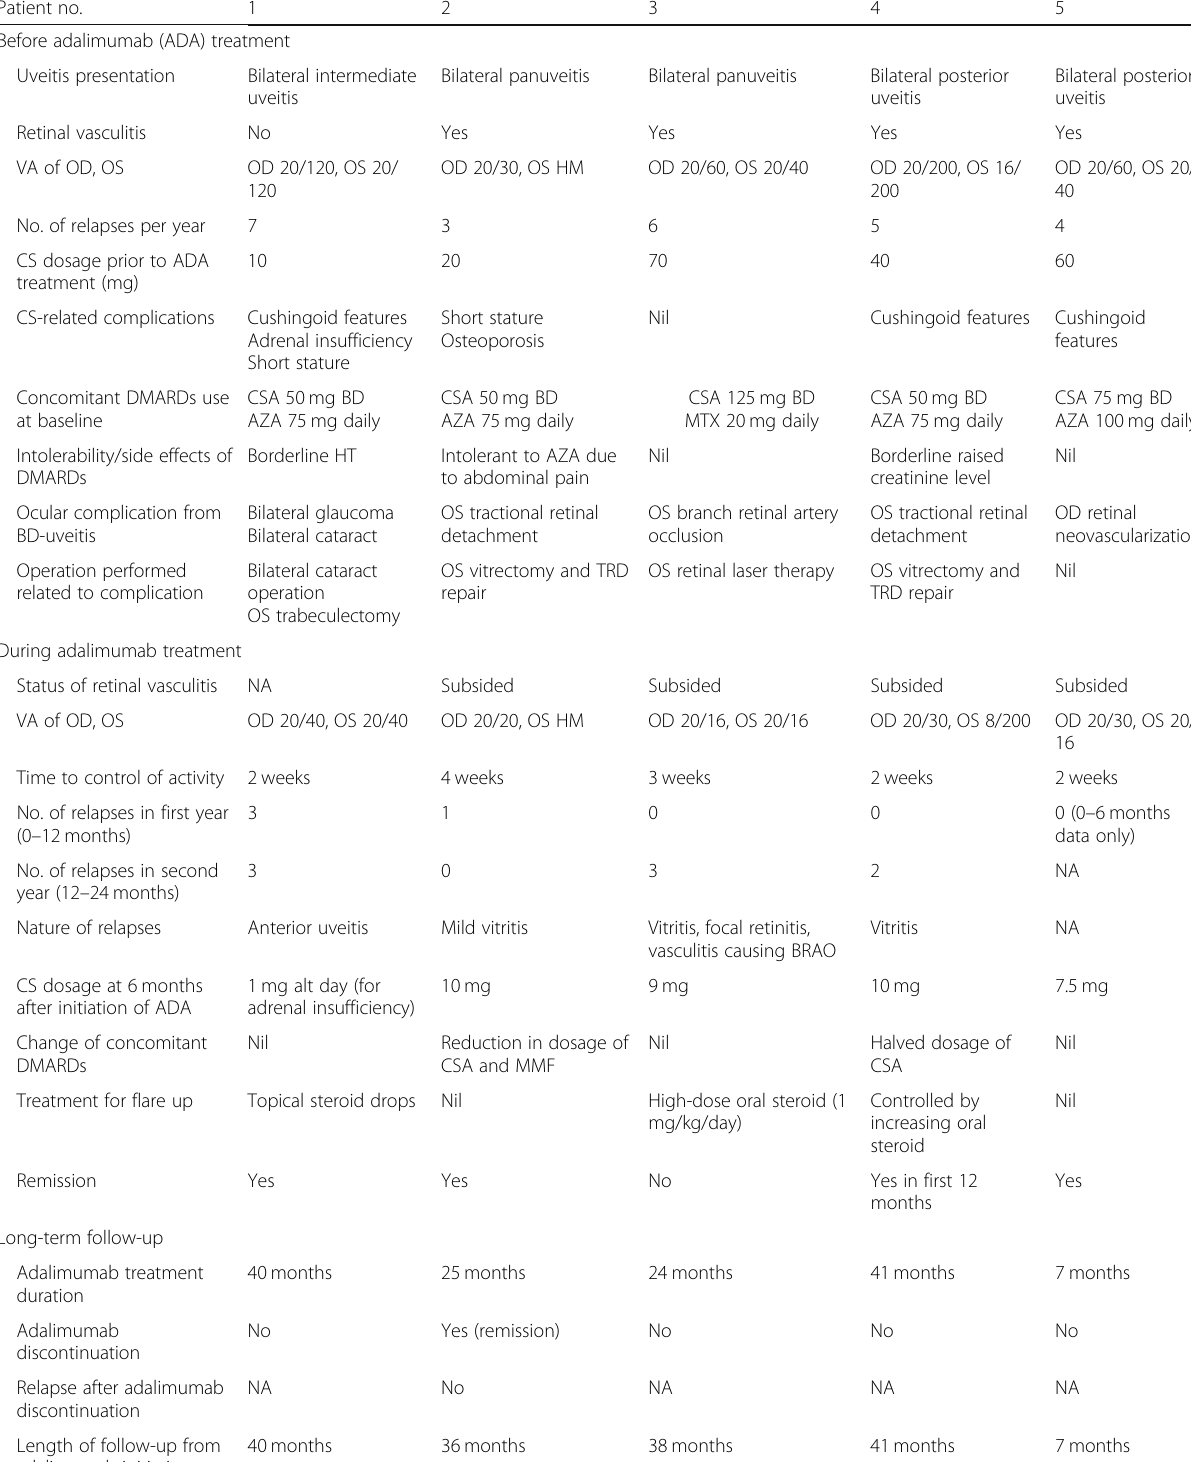
Table 2 Clinical response and treatment efficacy of adalimumab in BD-related uveitis Patient